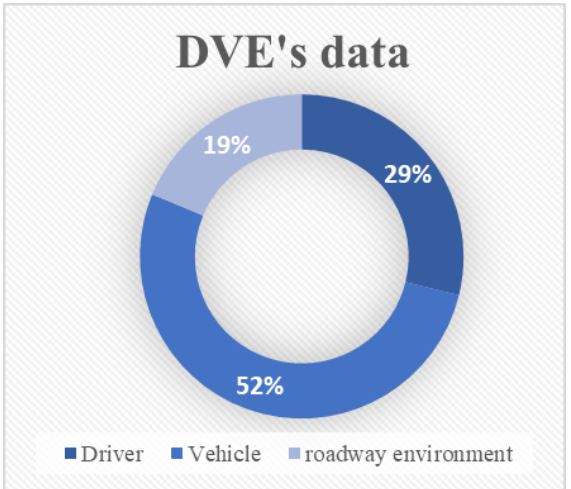
Figure 7. Driver, Vehicle and Environment related